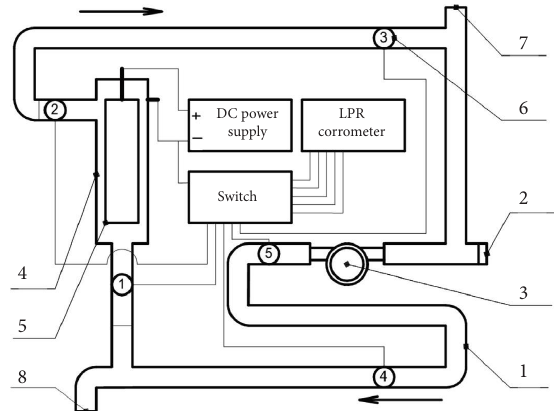
Figure 3: Te scheme of laboratory setup: 1—closed water circuit; 2—electric heater; 3—centrifugal pump; 4—steel unit; 5—magnesium anode; 6—LPR corrosion probes (1–5); 7—water inlet; 8—water outlet. Arrows indicate the water fow direction.